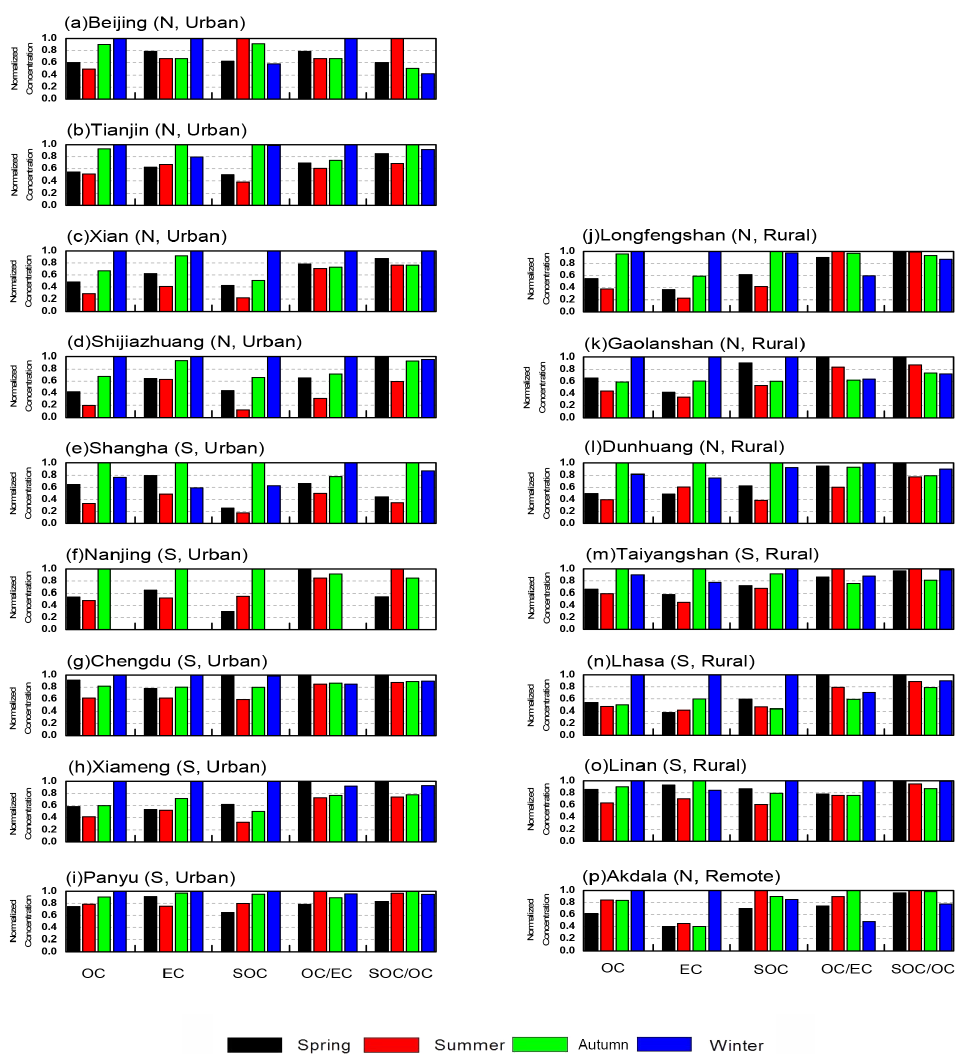
Figure 6. Seasonal variation of normalized OC, EC, SOC, OC / EC and SOC / OC in PM 2 . 5 (Beijing, Tianjin, Shijiazhuang, Shanghai, Nanjing, and Xiamen) or PM 10 (other cities) by region from various studies, including (1) urban sites: Beijing (Lin et al., 2009); Tianjin and Shijiazhuang (P. Zhao et al., 2013); Shanghai (Feng et al., 2009); Nanjing (Li et al., 2015); Xiamen (F. Zhang et al., 2012); Xi’an, Chengdu, and Panyu (X. Zhang et al., 2008, 2012); and (2) rural/remote sites: Longfengshan, Gaolanshan, Dunhuang, Taiyangshan, Lhasa, and Linan (X. Zhang et al., 2008, 2012); Akdala (Qu et al., 2009). N and S represent northern and southern sites,